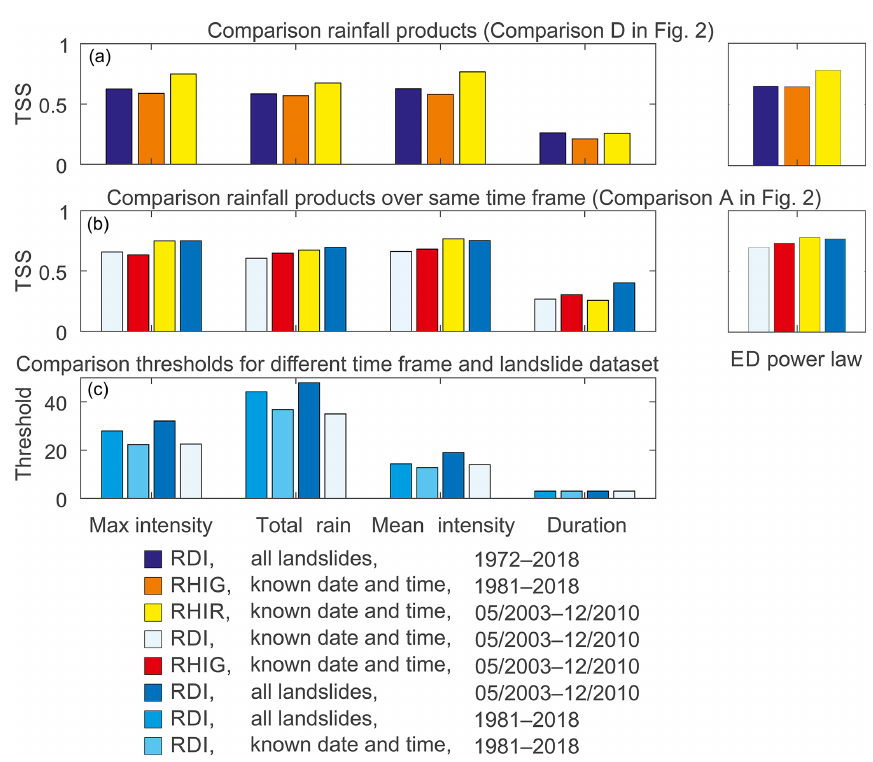
Figure 3. True skill statistic for the different precipitation characteristics and all the different rainfall dataset considered. (a) Comparison of rainfall products using for each rainfall dataset the entire time frame available. (b) Comparison of the overlapping time frame (May 2003– December 2010). The right subpanels in panels (a) and (b) show the performance of the ED power law threshold for the corresponding datasets as reference. (c) The optimum thresholds obtained with daily rainfall data and considering all time frames and landslides with known date and timing ( known timing ) or at least date ( all landslides